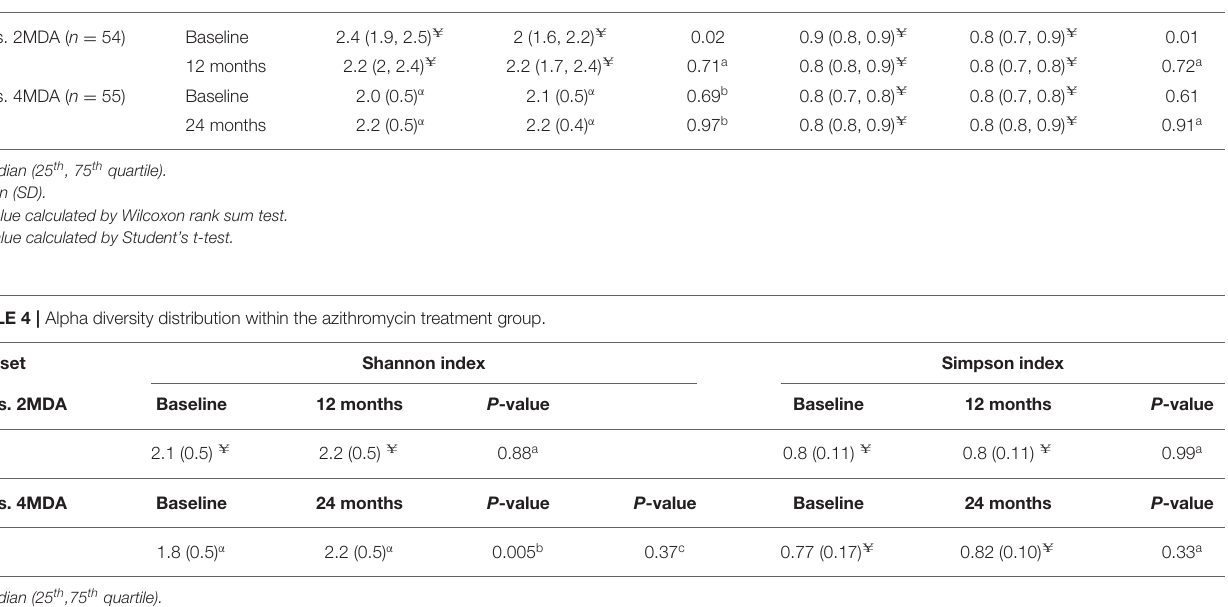
TABLE 3 | Alpha diversity distribution between treatment groups. Dataset